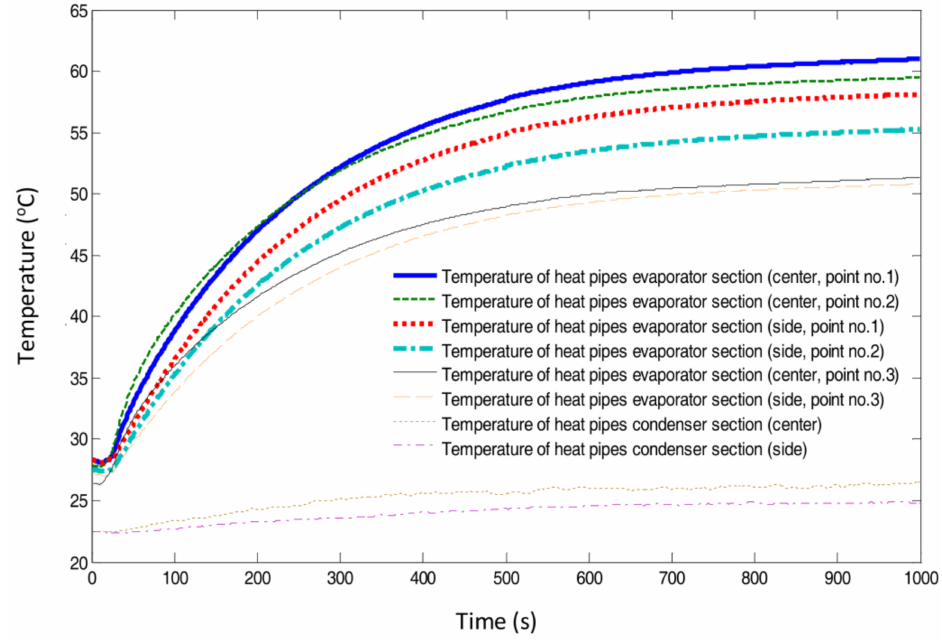
Figure 3. Temperature as a function of time in the evaporator and the condenser section of the heat pipes (diameter of 6 mm, effective length of 190 mm and pressed thickness of 2 mm and width of 8.50 mm at the evaporator section) in different locations (gravity orientation) using heat supply of 39